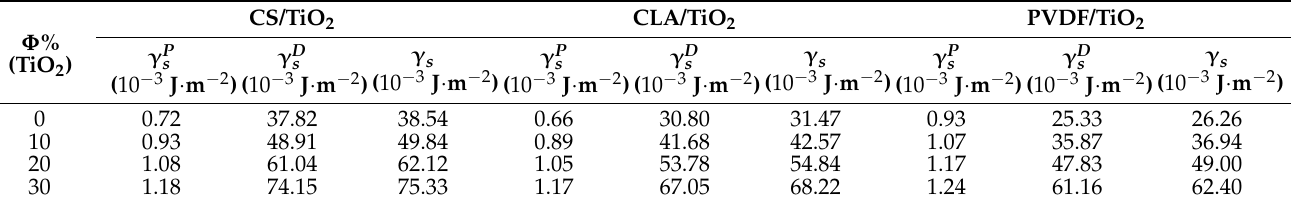
Table 5. Surface energy of CS/TiO 2 , CLA/TiO 2 and PVDF/TiO 2 nanocomposites as function of volume fraction of TiO 2